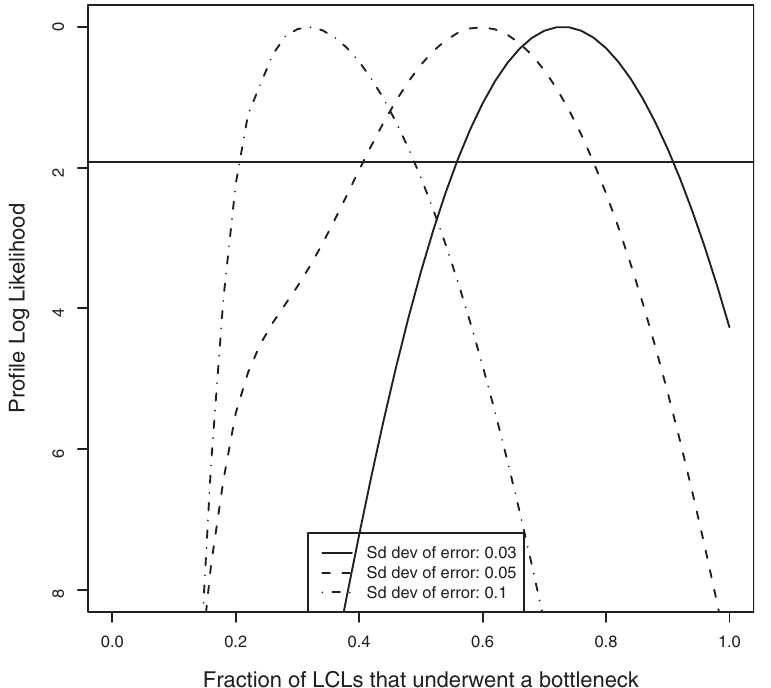
Figure 2. Likelihood curve for the fraction of cells f that underwent a bottleneck. We considered three values for the standard error in the measurement of the skew in X inactivation (standard deviation of 0.03, 0.05 and 0.1). The horizontal line indicates the 95% confidence interval.